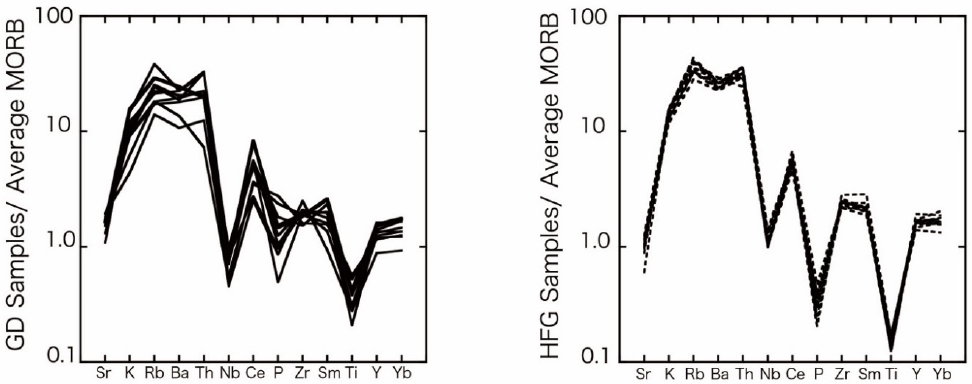
Figure 8. Spider diagrams for the rocks in the Hisakajima Island (normalized to average MORB [22]).